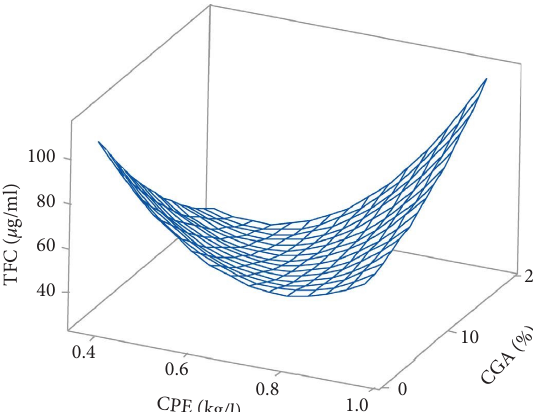
Figure 6: Response surface for total favonoid content of coated tomatoes as function of pineapple peel extract concentration and Arabic gum